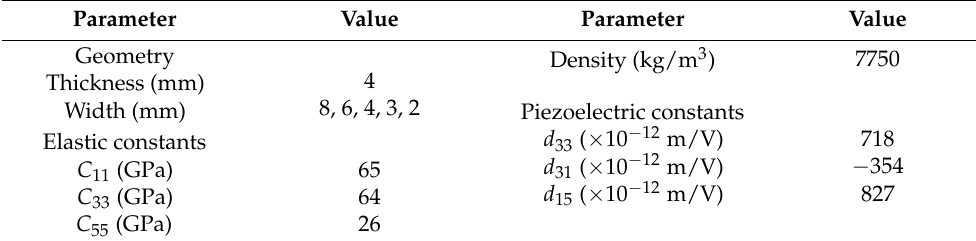
Table 2. Parameters of soft PZT C9 used for 2D FE simulation.